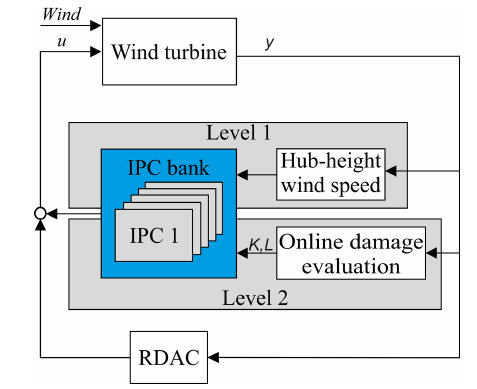
Figure 5. The aIPC switching